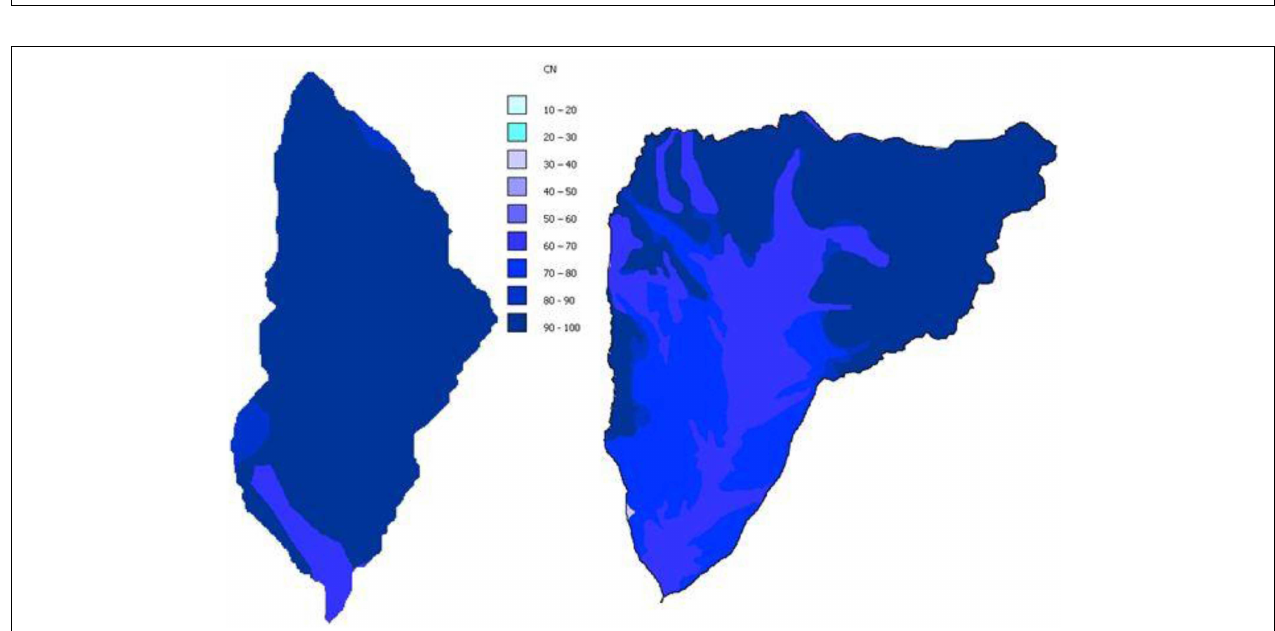
FIGURE 4 | Conceptual sketch of the model of Gregoretti and Dalla Fontana (2008).